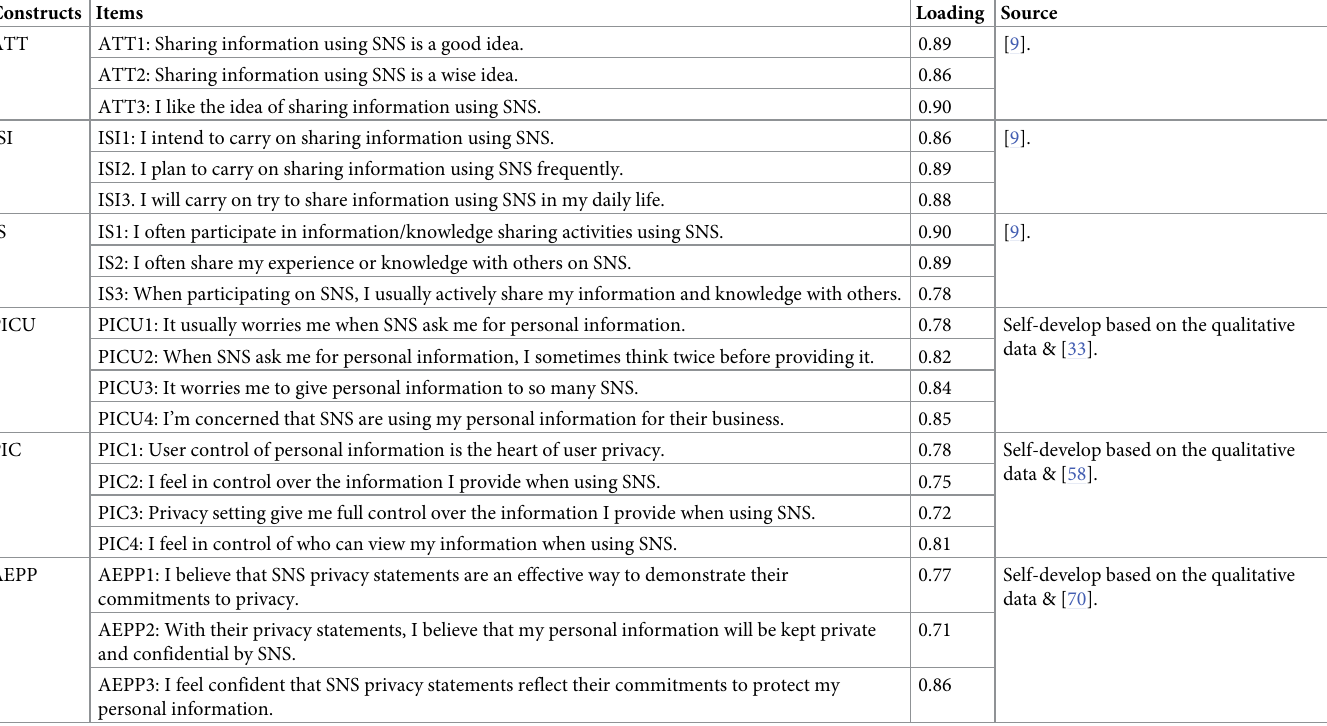
Table 4. Constructs, items with factor loadings, and sources.